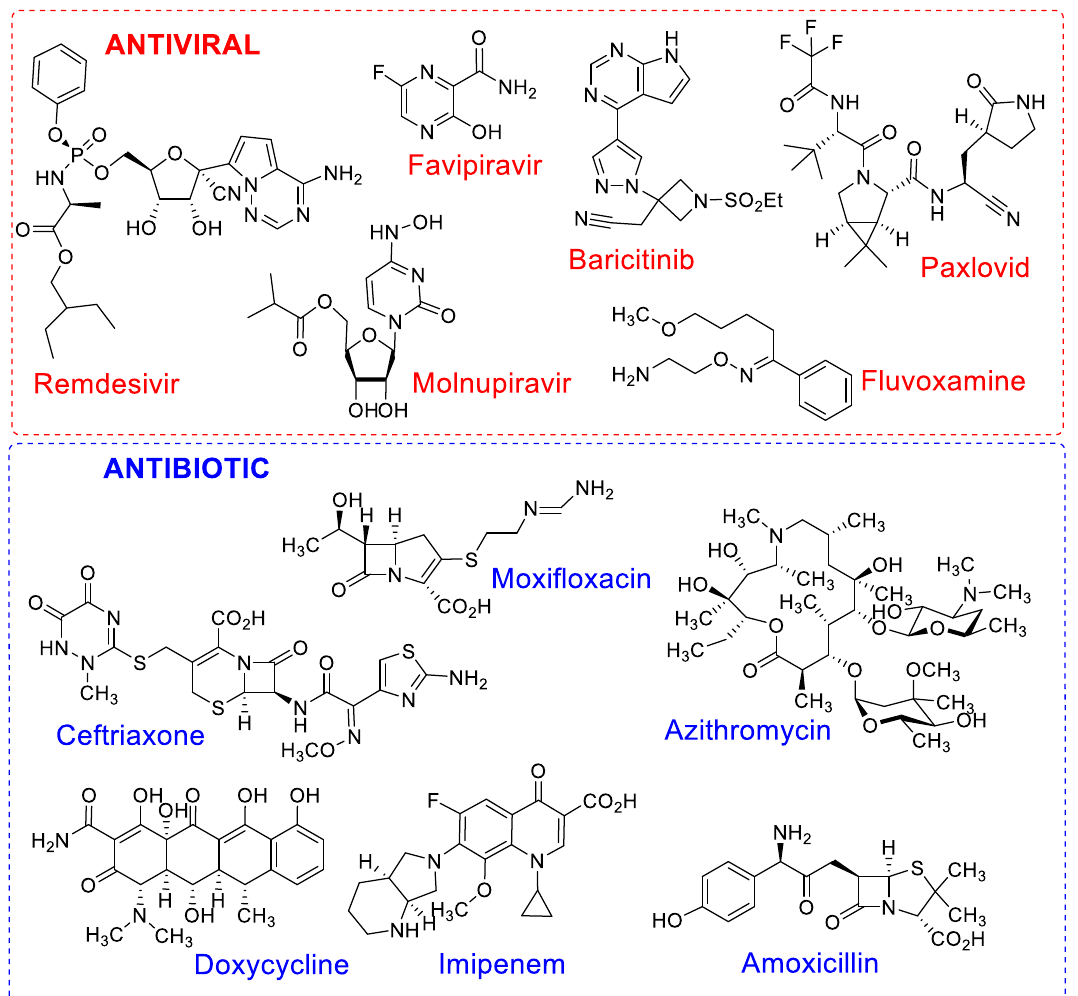
Figure 1. Chemical structures of antiviral and antibiotic drugs with different mechanisms of action used in mono or combination therapy in the treatment of patients with COVID-19. used in mono or combination therapy in the treatment of patients with